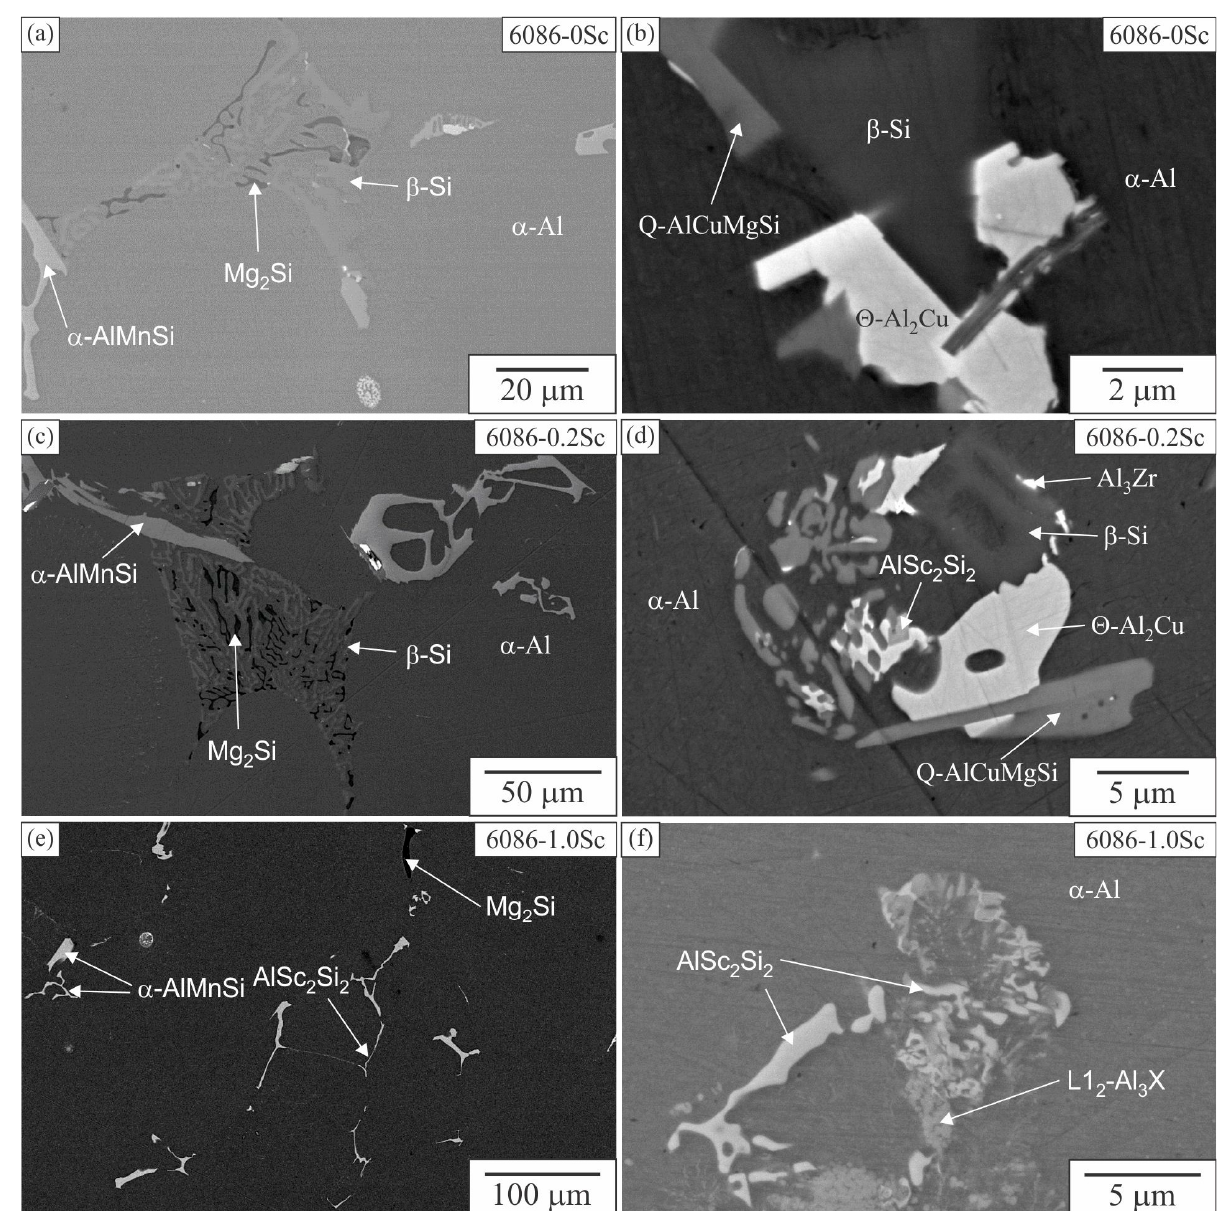
Figure 9. BSE electron micrographs of the investigated alloys after DSC with a cooling rate of 10 °C/min. The alloy 6086-0Sc at ( a ) a lower and ( b ) a higher magnification; the alloy 6086-0.2Sc at ( c ) a lower and ( d ) a higher magnification and the alloy 6086-1Sc at ( e ) a lower and ( f ) a higher magnification.